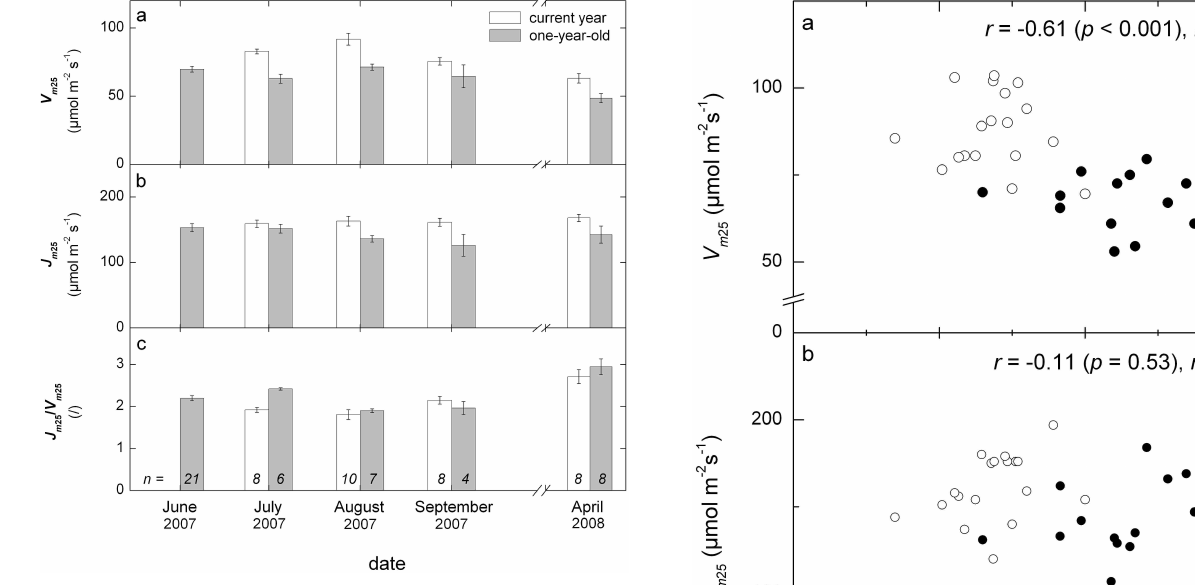
Fig. 2. Seasonal variation of (a) maximum carboxylation capac- ity at 25 ◦ C ( V m25 ) , (b) maximum electron transport capacity at 25 ◦ C ( J m25 ) , and (c) the J m25 /V m 25 ratio, for current-year nee- dles (white bars) and one-year-old needles (grey bars). Error bars represent SE. In June 2007, current-year needles were too small to be sampled.